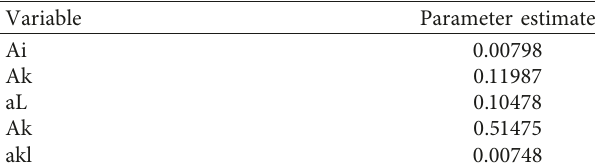
Table 8: Parameter estimates of transcendental logarithm pro- duction function based on principal component